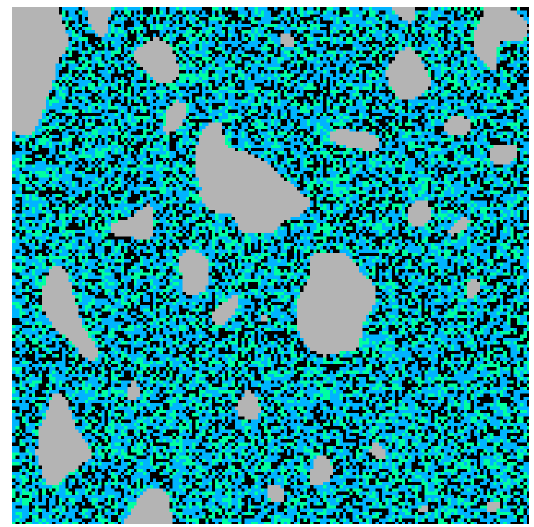
Figure 7. Artificially created microstructure based on Figure 5, featuring an enforced uniform distribution of hydrates in space; image size 158 × 158 pixels capturing an area of 150 × 150 µm 2 ; color map corresponds to Figure 3.